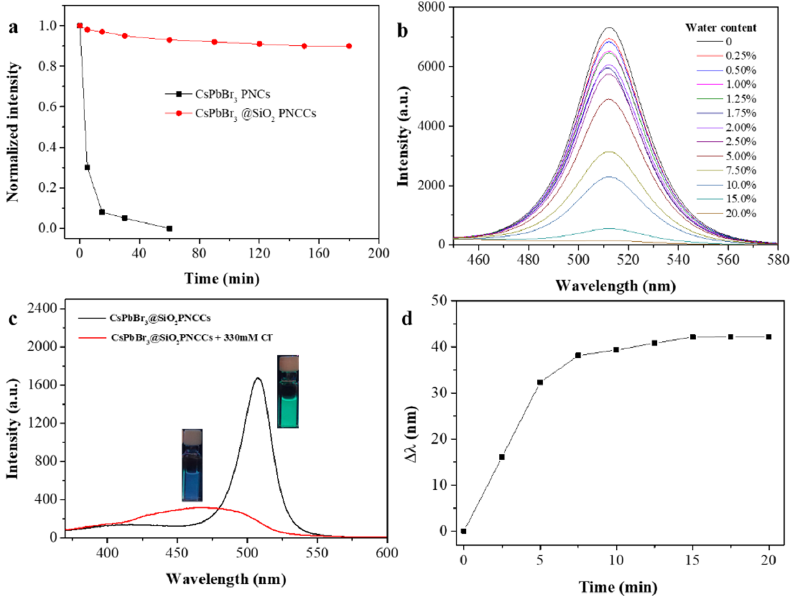
Figure 6. ( a ) Stability comparison between CsPbBr 3 @SiO 2 PNCCs and CsPbBr 3 PNCs in ethanol; ( b ) CsPbBr 3 @SiO 2 PNCCs in ethanol solution react with H 2 O at different concentrations; ( c ) homogeneous halide exchanges between CsPbBr 3 @SiO 2 PNCCs and Cl − and their reaction optimization ( d ).